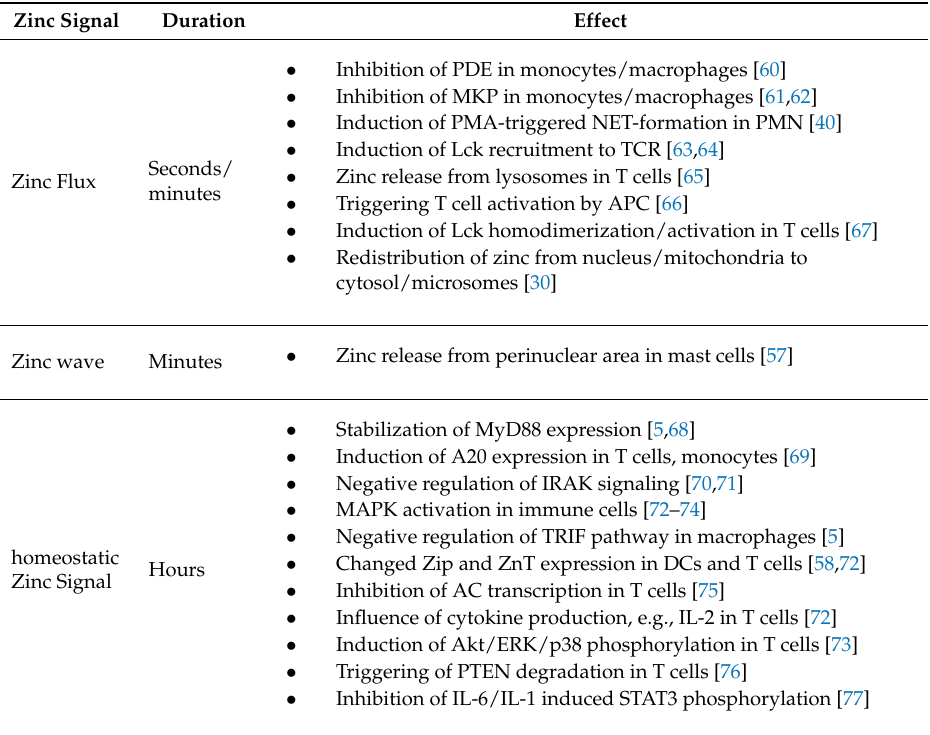
Table 1. Effect of zinc signals on Immune function: Altered immunological functions can be